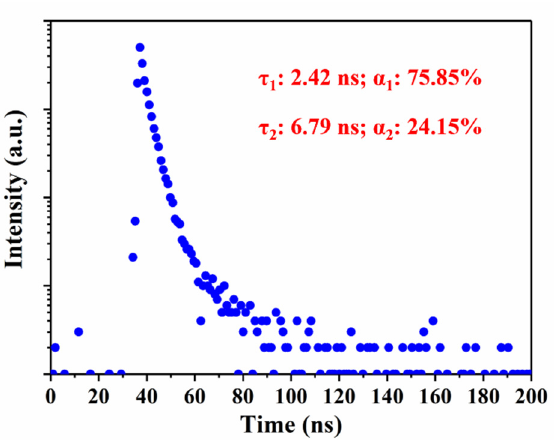
Figure 6. Fluorescence decay profile of CQDs/PC.